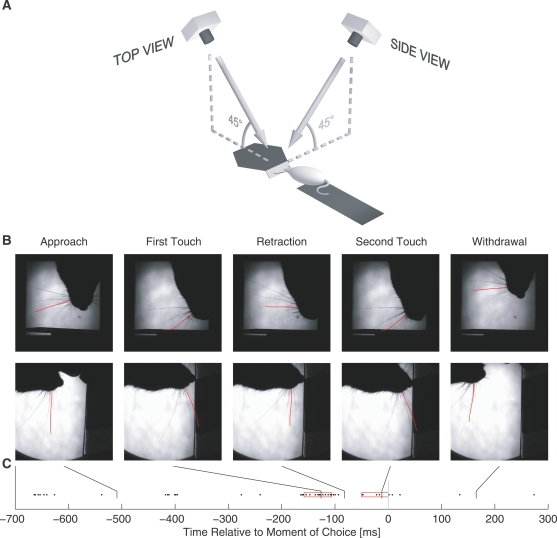
Behavior and Neuronal Activity in a Typical Trial(A) Spatial arrangement of the two high-speed cameras.(B) Images from high-speed films taken from two different views (top row—top view, bottom row—side view, see [A] for positions; frame pairs of the upper and lower rows are synchronous). Whisker C2 is traced. Although in the side view, the rat's snout seemed to touch the texture, the corresponding top view frames show that this was not the case. Although on a small proportion of trials, rats were close enough that microvibrissae contact could not be excluded, this happened too rarely to explain the animals' high performance.(C) Spikes fired by a neuronal cluster whose receptive field was centered on whisker C2. Estimated moment of choice is given by gray vertical line at 0 ms. Contacts of the selected whisker before decision are marked as red frames. Note the increase in firing rate during contact. Contacts after choice are not highlighted, and the corresponding spikes were not considered in the analysis. Shown: rat 16, session 2006-07-23, cluster #58, trial 20, smooth texture.